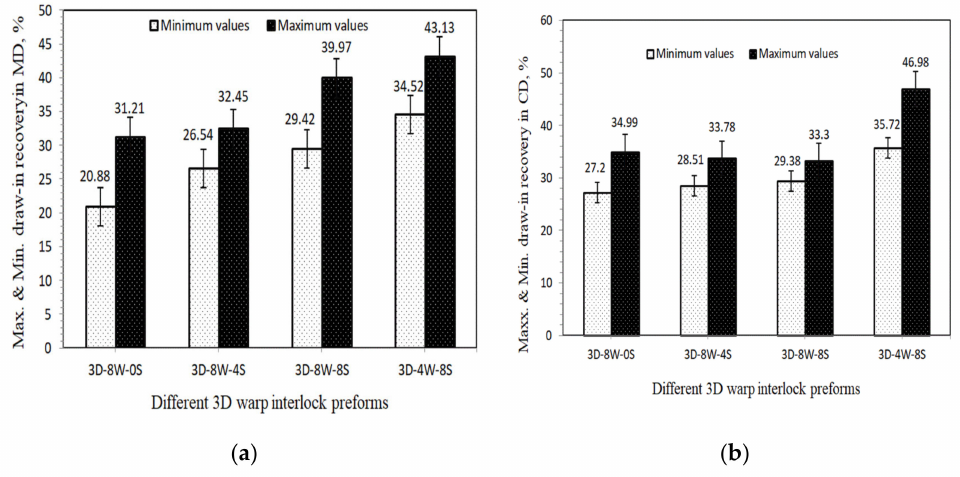
Figure 18. The maximum and minimum drawing-in recovery values of 3D warp interlock preforms after forming in ( a ) machine and ( b ) cross